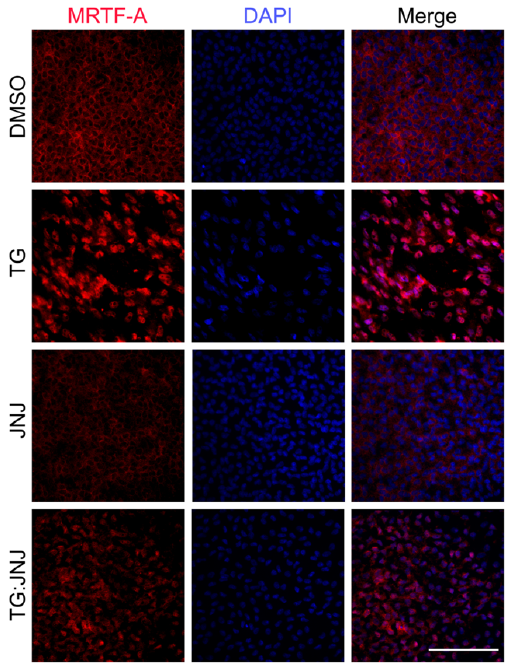
Figure 9. Localization of myocardin-related transcription factor-A (MRTF-A) upon MMP9 inhibition. Rat LEC explants were treated with <5% DMSO, with 6 ng/mL TGF- β for 48 h (TG), with 20 µ M JNJ0966 (JNJ) for 48 h, or pretreated with 20 µ M JNJ0966 for 2 h followed by 6 ng/mL TGF- β for 48 h (TG:JNJ) ( n = 3 independent experiments, where n ≥ 3 LECs per treatment were used for each experiment). Paraformaldehyde (PFA) fixed explants were stained for MRTF-A (red) and mounted with DAPI to visualize the nuclei. Images were acquired using Leica DM6 fluorescence microscope at 40×. Scale bar 100 µm.